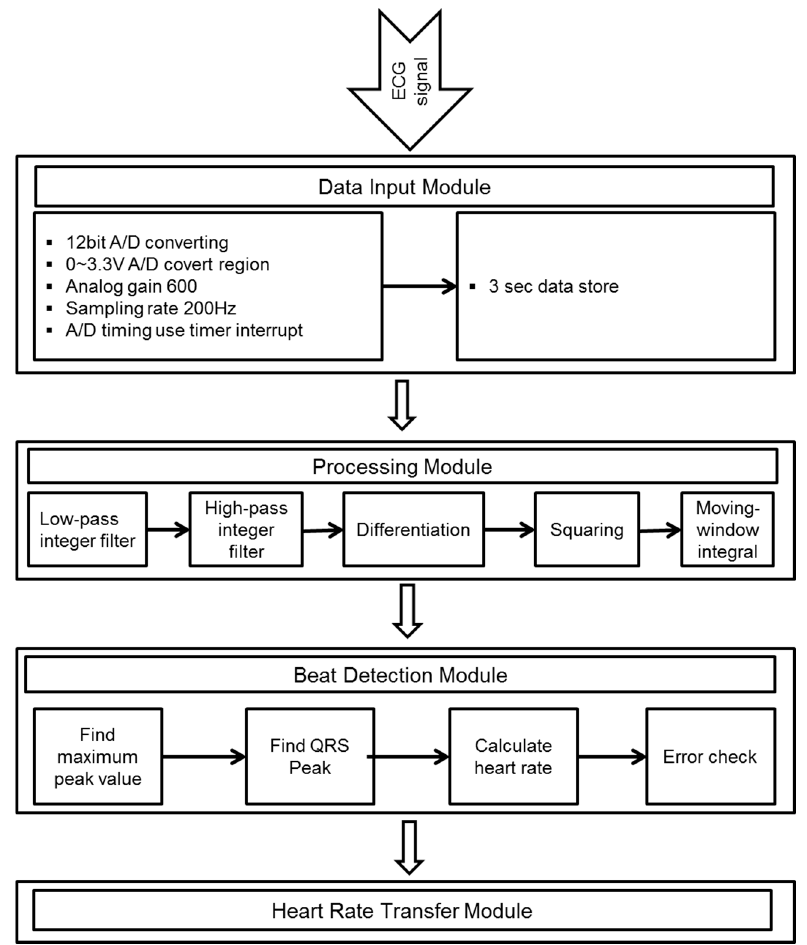
Figure 3. Algorithm for heart rate calculation. A/D = analog-to-digital.